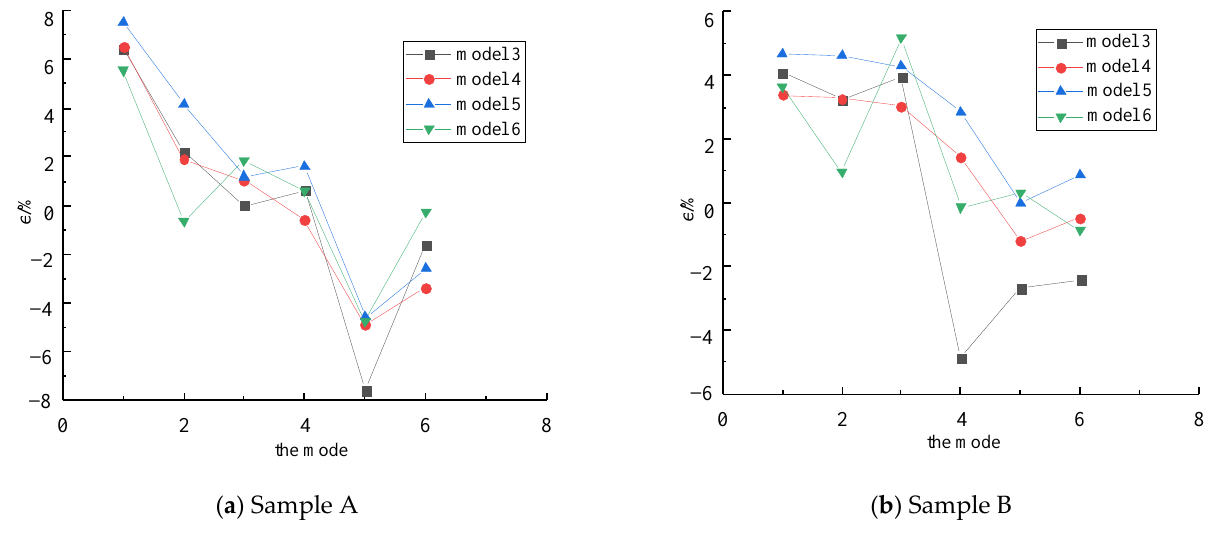
Figure 9. Relative error of natural frequency of simplified model